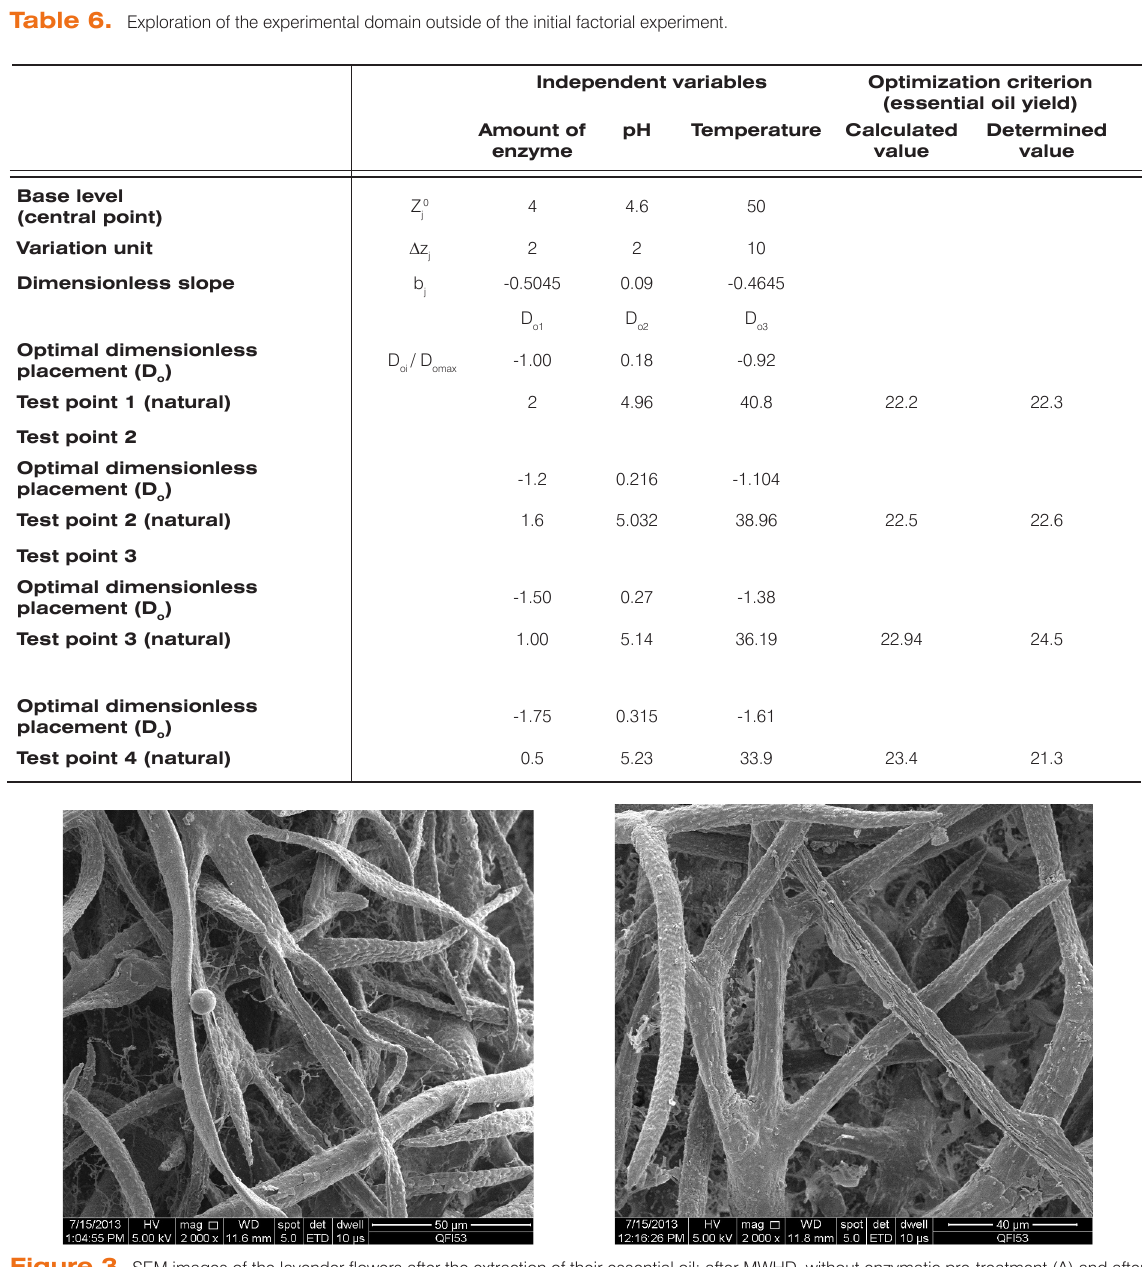
Figure 3. SEM images of the lavender flowers after the extraction of their essential oil: after MWHD, without enzymatic pre-treatment (A) and after MWHD, with enzymatic pretreatment